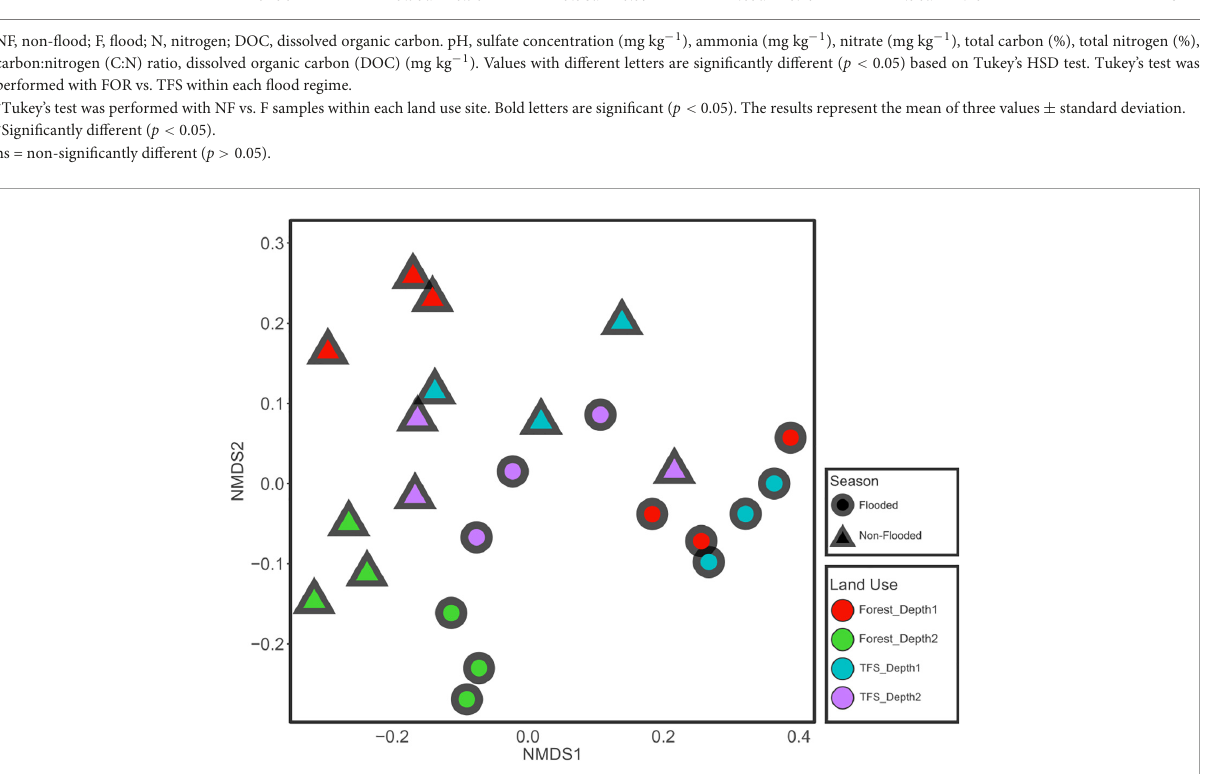
contributions. The intersection between all four factors (0.360%) and between all three edaphic factors (0.122%) had the lowest values ( Figure 3B ). The majority of the AOB variance